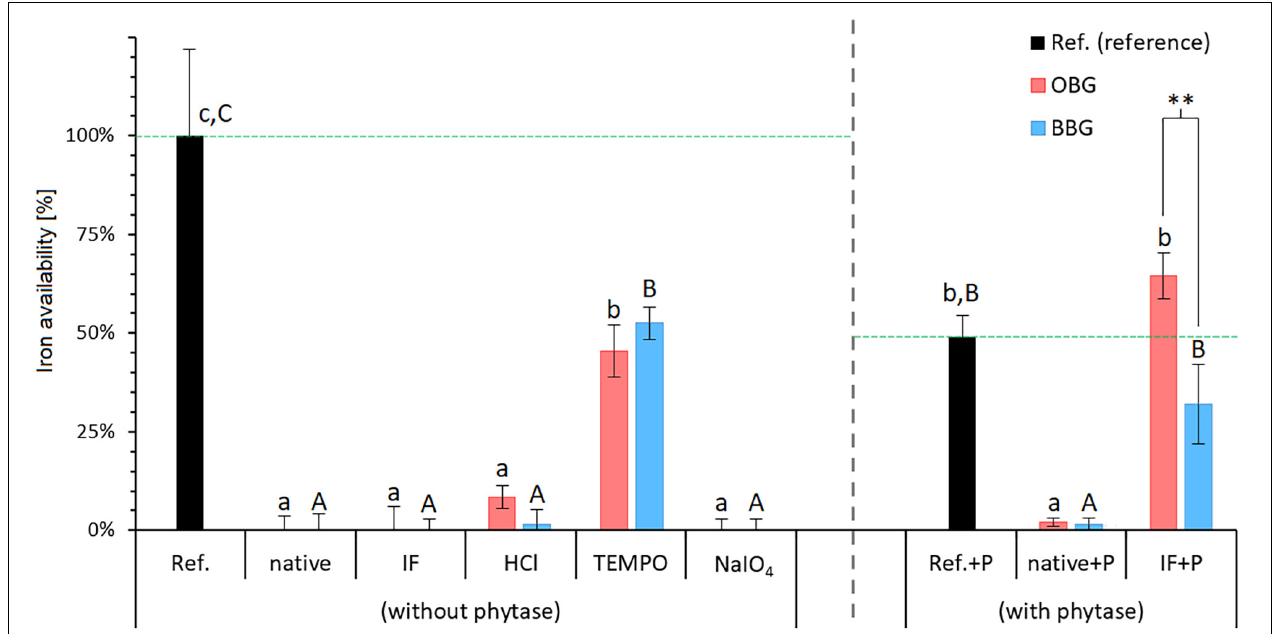
FIGURE 5 | Iron availability in the presence of various dissolved native or modified β -glucan extracts from oat (OBG) and barley (BBG) obtained from the in vitro digestion study. The available iron as measured by the amount that crossed the dialysis membrane from the digestion mixture is presented as percentages relative to the reference (Ref.; no β -glucan added). Horizontal dashed lines in green emphasise the 100% reference levels for regular (without phytase) and phytase-treated samples (with phytase). Note that for the samples with phytase (+P), the reference (Ref.+P) exhibits a substantially lower available iron content of 49% compared to the regular reference [Ref. (without phytase) = 100%; corresponding to a blank-corrected concentration of 20.6 µ M iron in the dialysate]. Different lowercase and uppercase letters indicate statistically significant differences within oat and barley samples, respectively ( p < 0.05). Differences between oat and barley samples of the respective type are indicated by asterisks ( ∗∗ , p ≤ 0.01).